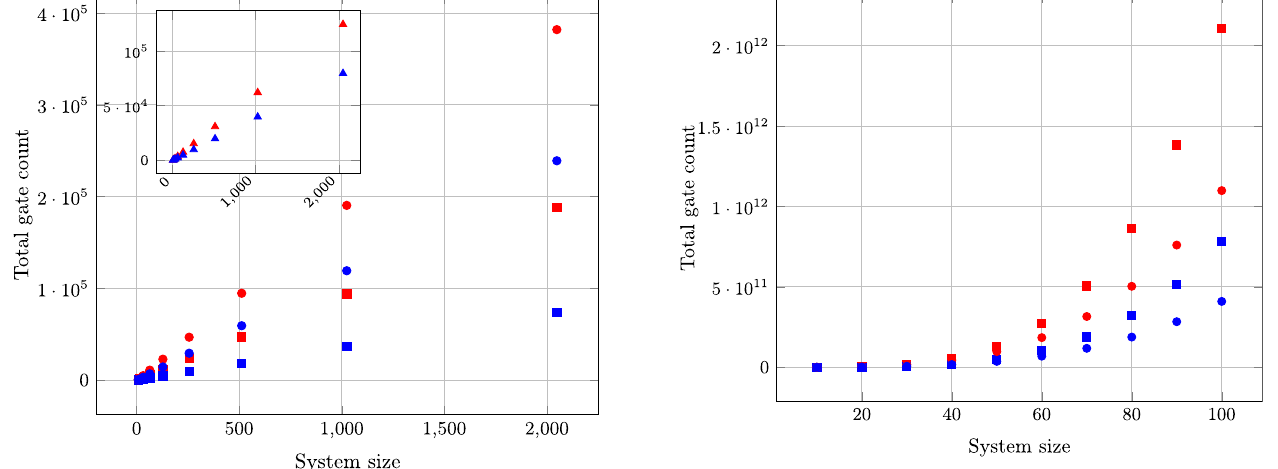
Fig. 1 Total gate count for the approximate quantum Fourier transform (QFT, inset), Quipper library adder, and Fourier-based adders (QFA). The points in red/blue represent gate counts before/ after optimization and the symbols square/circle/triangle represent gate counts for the Quipper library adder/QFA/QFT, respectively